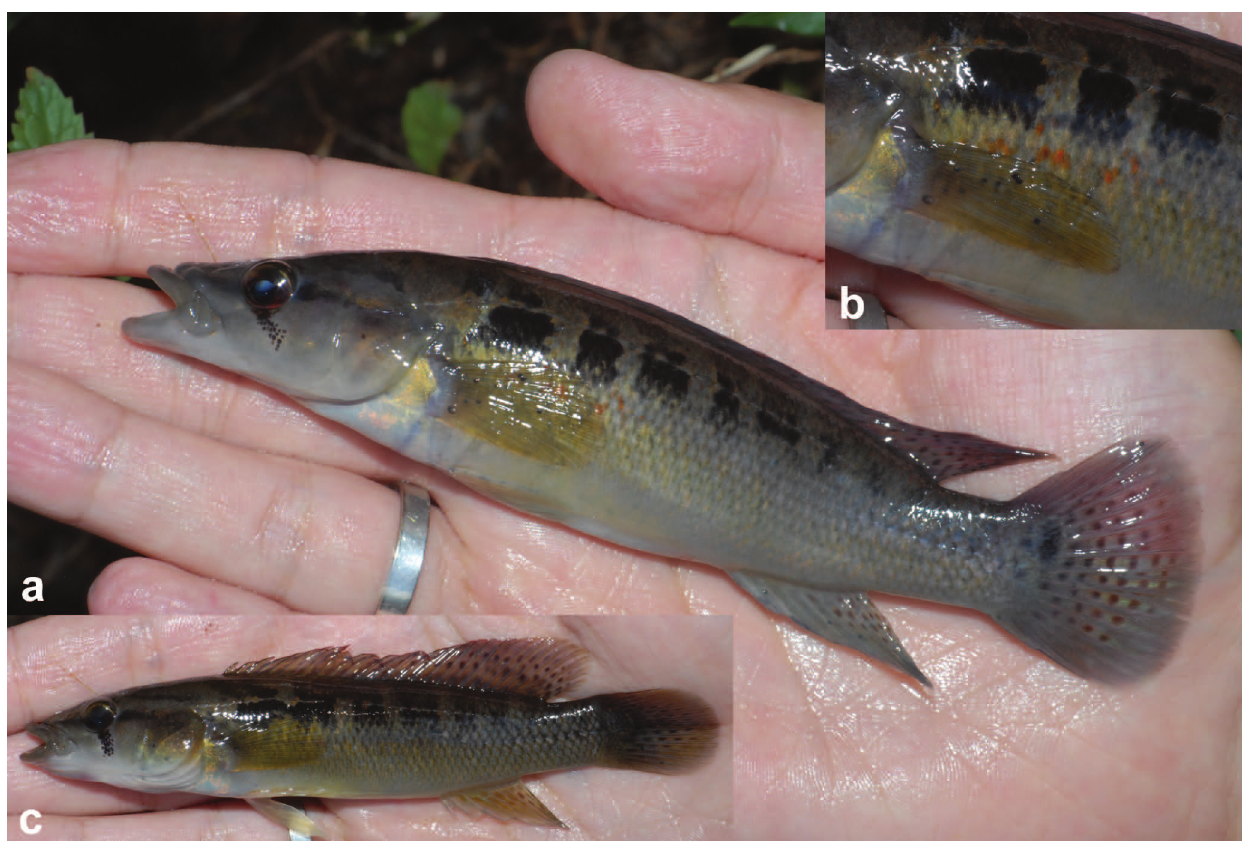
Fig. 2. Crenicichla ypo , AI 212, live male paratypes: a ) 113.1 mm SL; b ) detail of the orange dots on flank; and c ) 102.7 mm SL, showing a spotted dorsal